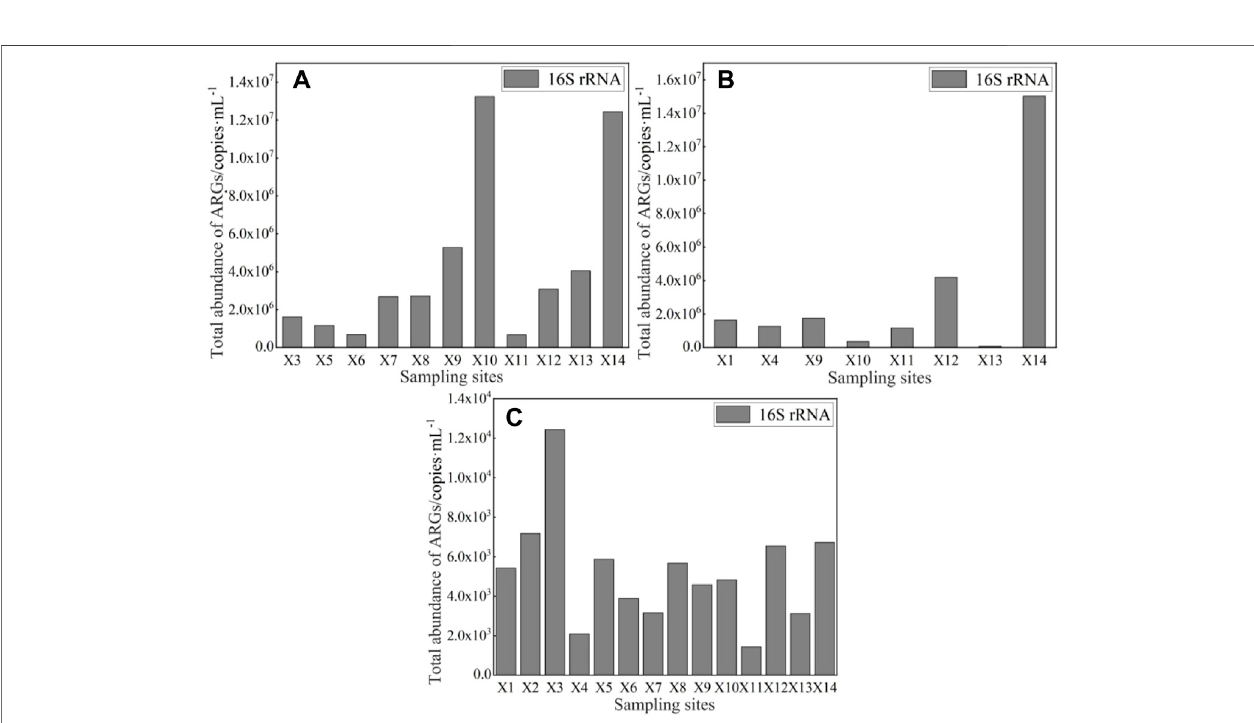
FIGURE 5 | Absolute abundance of 16S rRNA in the surface water of East Dongting Lake in spring (A) , summer (B) , and fall (C) .